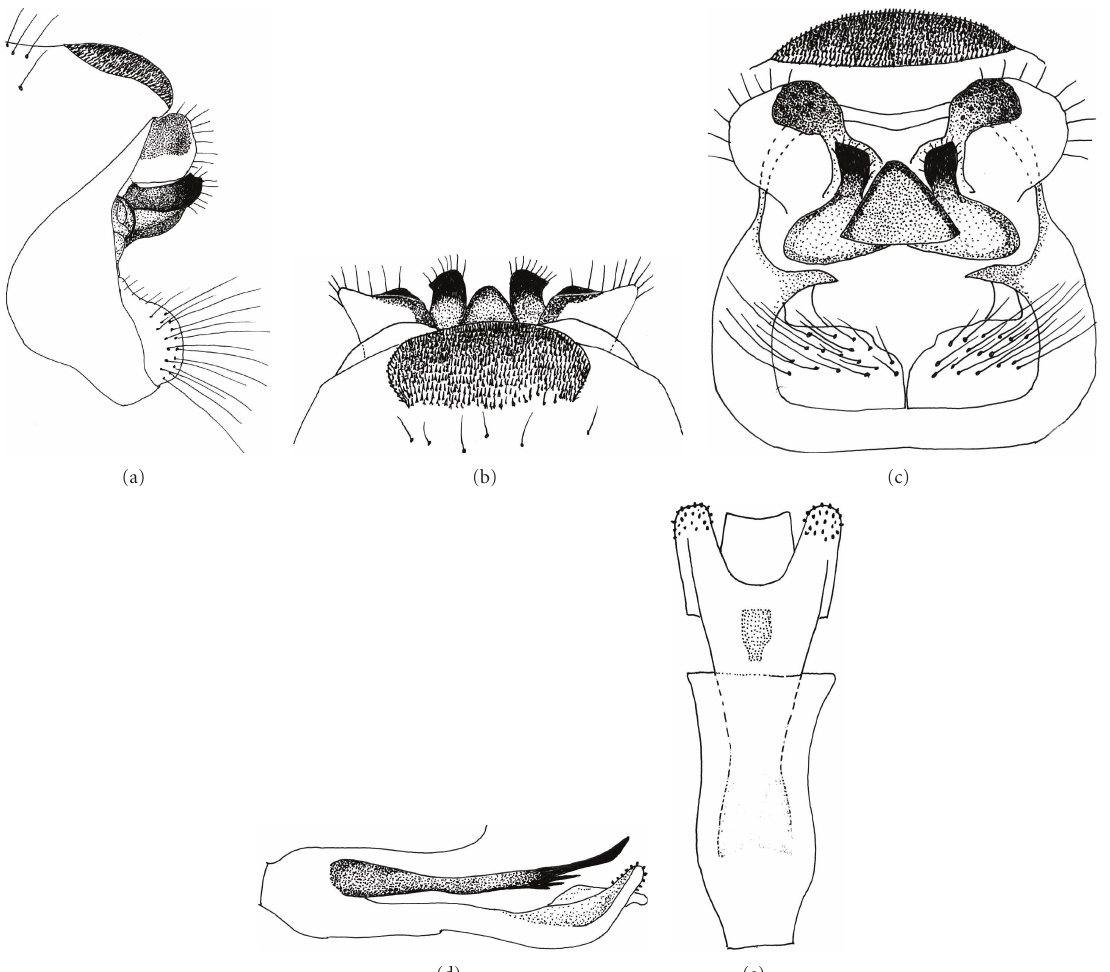
Figure 1: Chaetopteryx akgolensis sp.n., male genitalia: (a) lateral; (b) dorsal; (c) caudal; (d) phallic apparatus, lateral; (e) phallic apparatus,